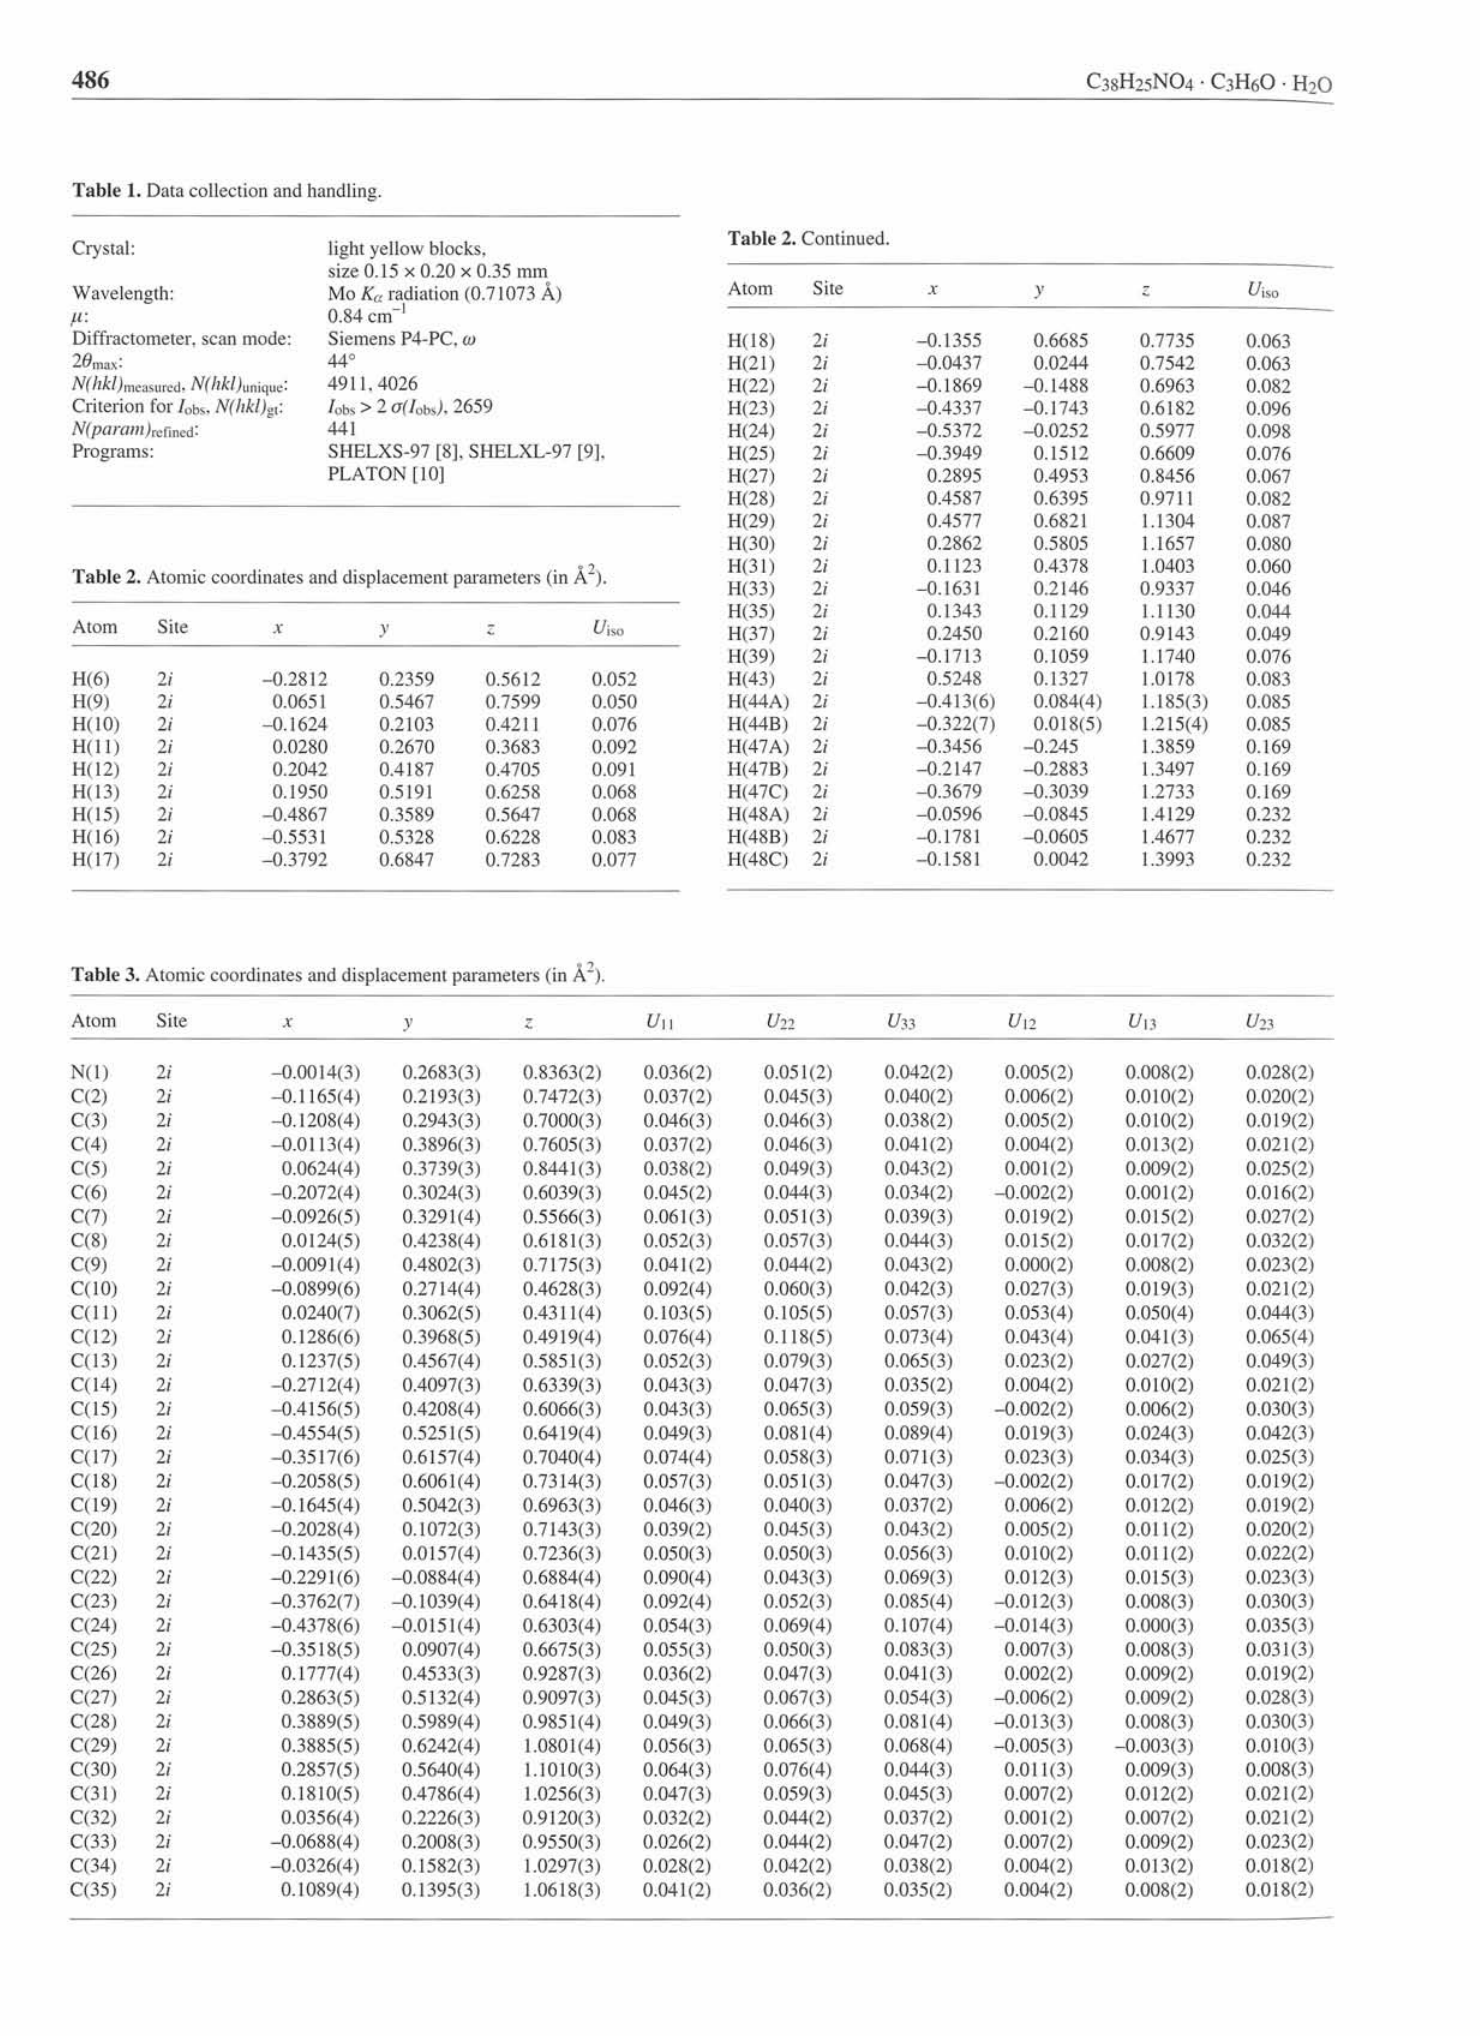
Table 2. Atomic coordinates and displacement parameters (in Á 2 ).